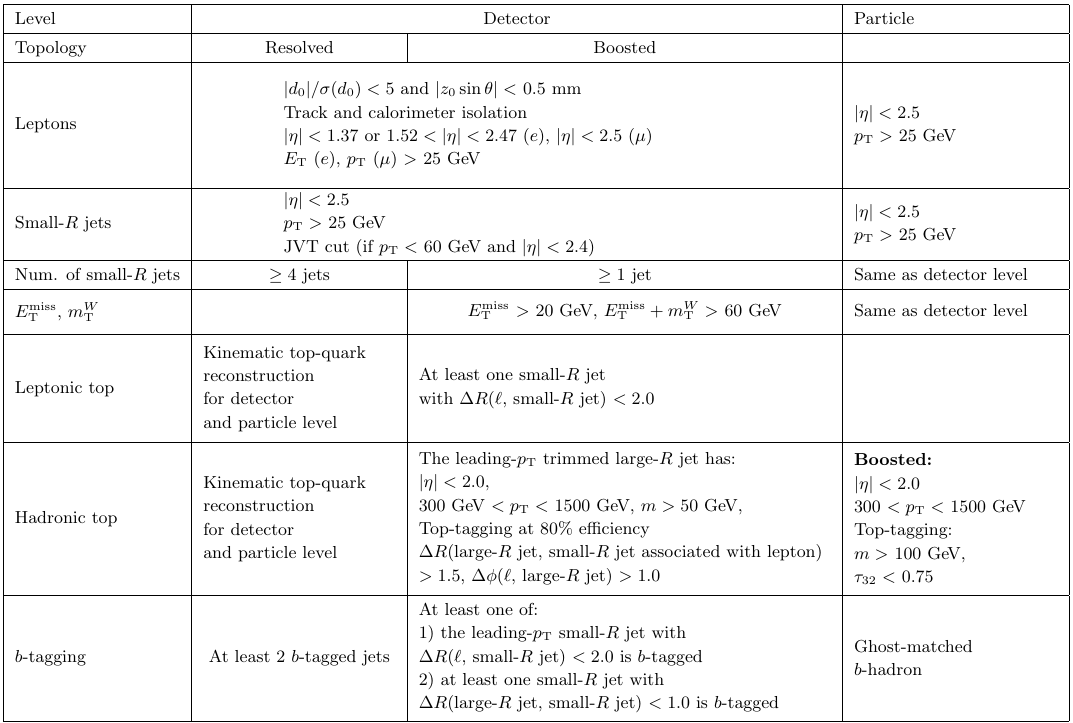
Table 2. Summary of the requirements for detector-level and MC-generated particle-level events, for both the resolved and boosted event selections. The description of the particle-level selection is in section 4.3. The description of the kinematic top-quark reconstruction for the resolved topology is in section 6. Leptonic (hadronic) top refers to the top quark that decays into a leptonically (hadronically) decaying W